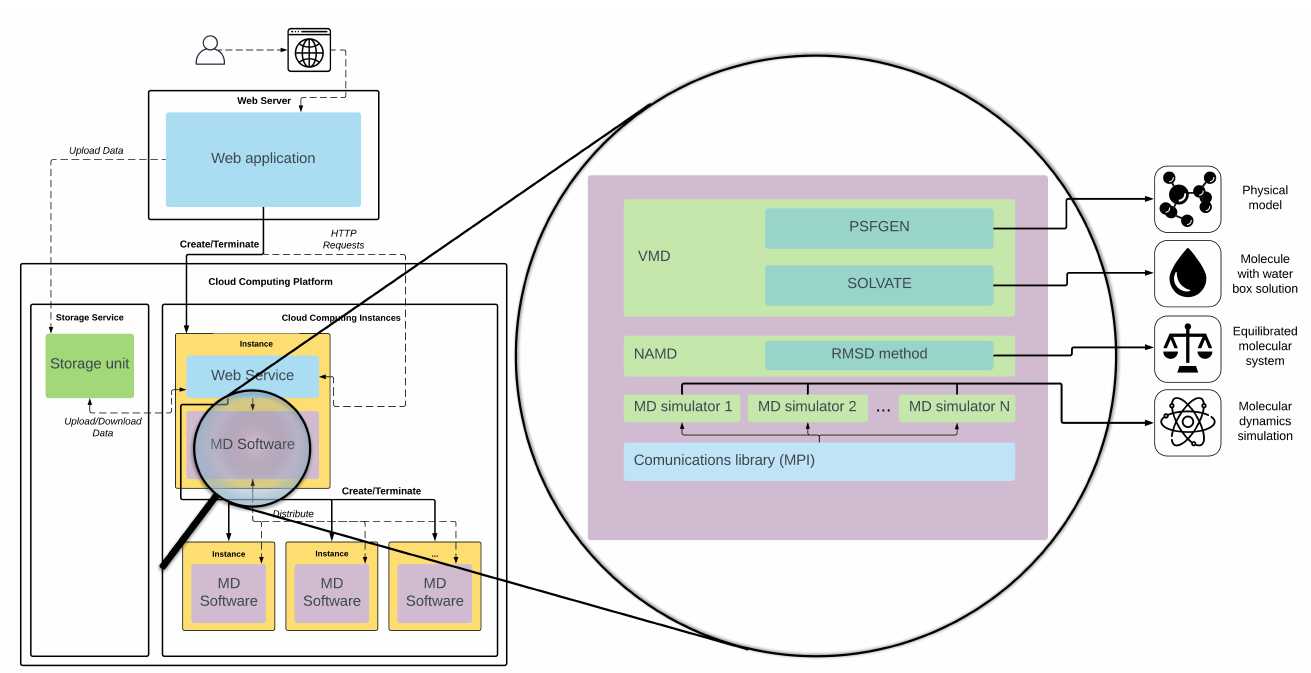
Figure 2. Cloud architecture diagram. Blue components belong to our proposed tool. In yellow are the custom instances that we have designed to run the MD software and communicate with each other and with our application. Green components belong to the cloud